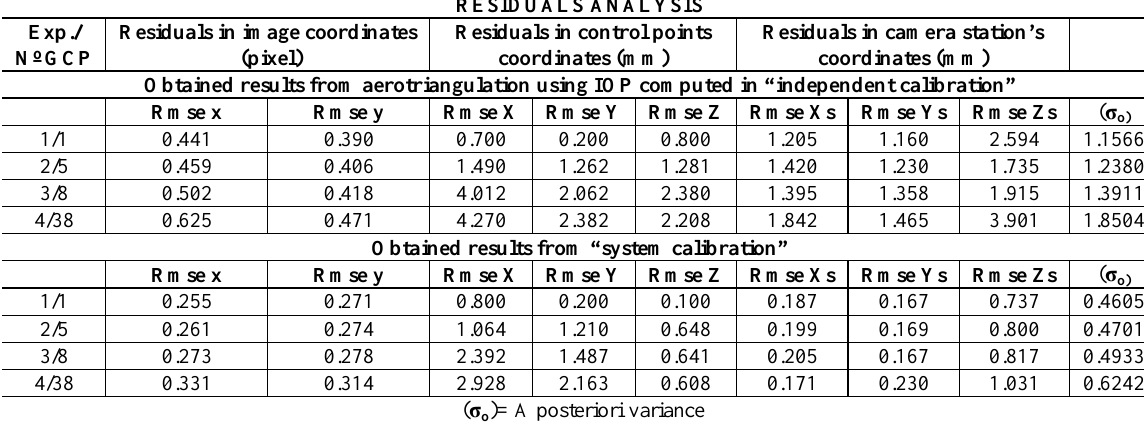
Table 4. Main results of the residuals analysis performed in the experiments with aerotriangulation and system calibration